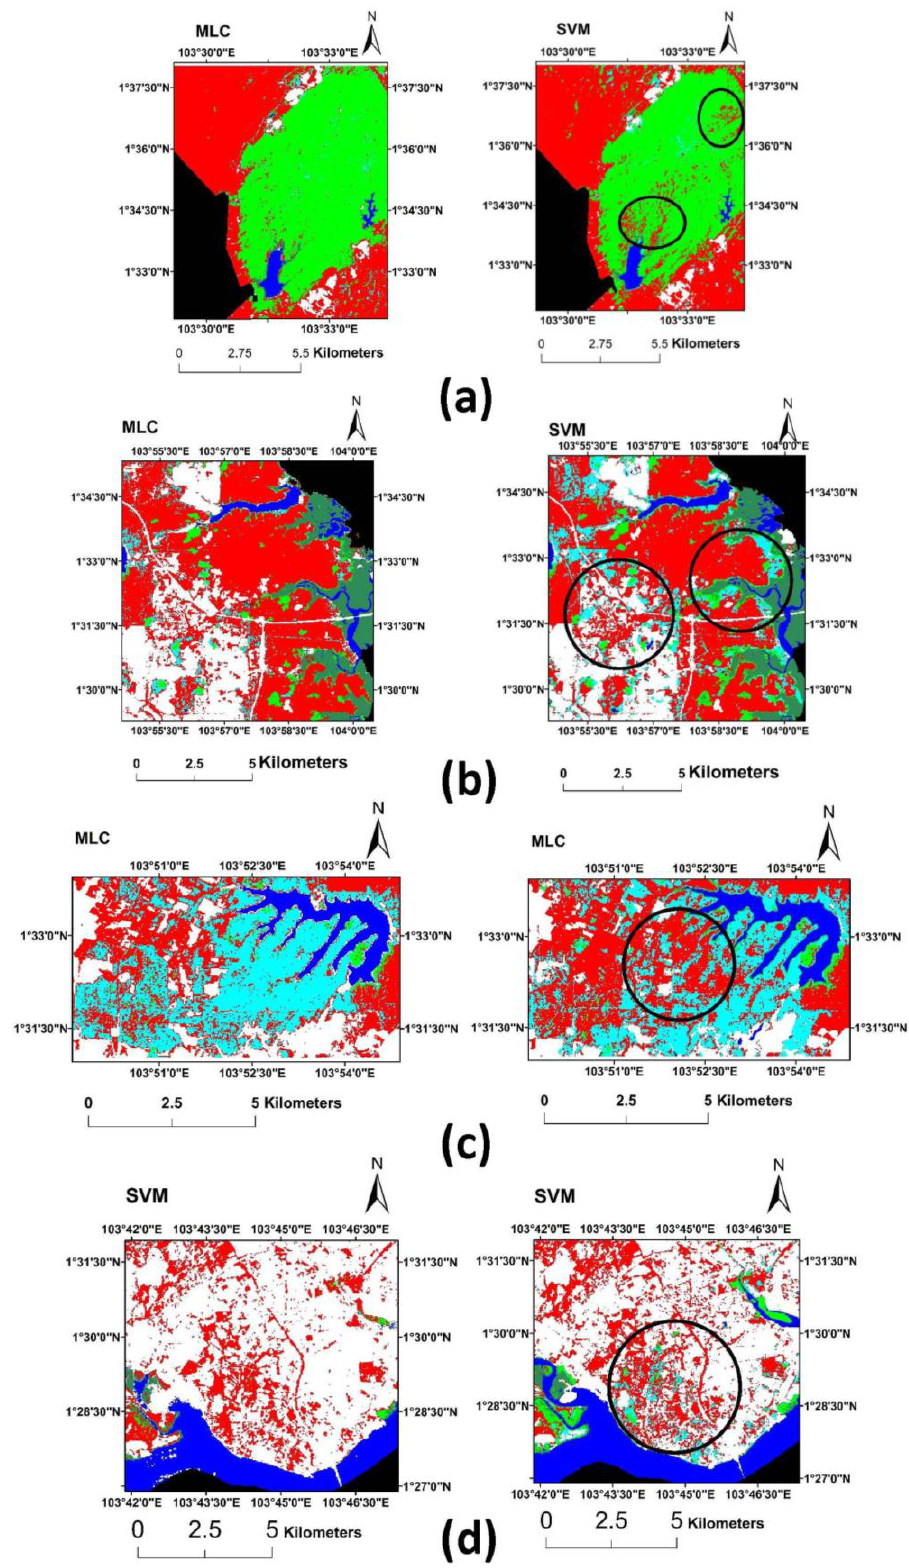
Figure 5. Subsets of images (2009) as classified by Maximum Likelihood Classification and Support Vector Machine techniques using 30 samples covering ( a ) Forest; ( b ) Mangrove; ( c ) Rubber; and ( d ) Urban areas in Iskandar Malaysia. The circles show “salt and pepper” effect on images classified by SVM compared to MLC